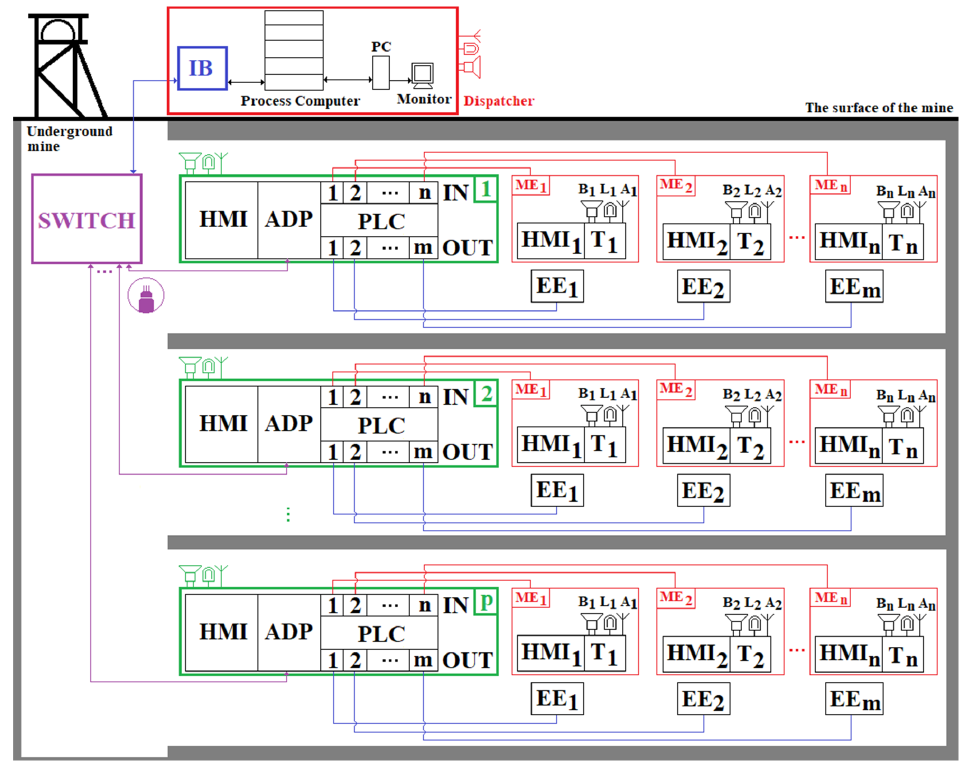
Figure 5. The architecture of the personnel tracking and monitoring system for the underground mine.